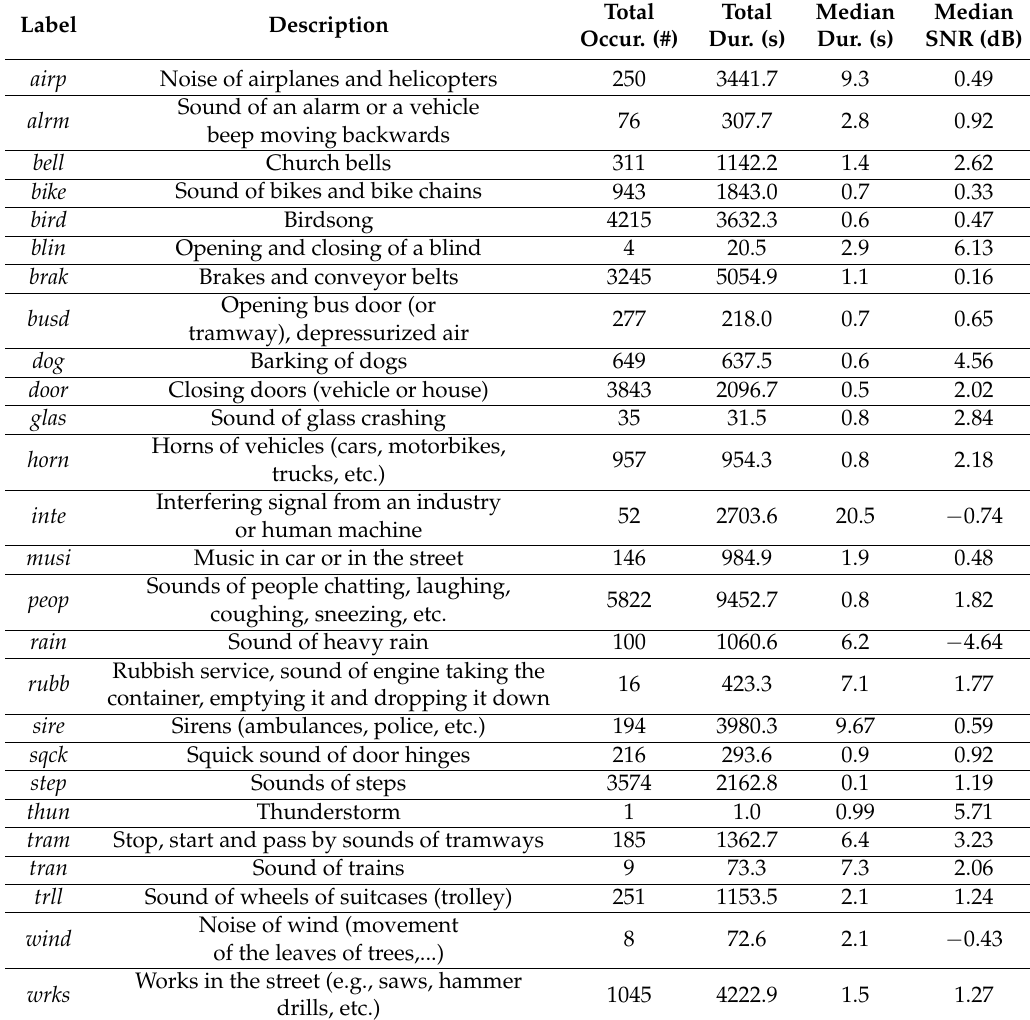
Table 2. Description of the 26 sound subcategories of anomalous noise events, in alphabetical order, identified during the manual labelling process of the WASN-based urban acoustic database, showing the number of occurrences, their total duration (in s), median duration (in s) and median signal-to-noise ratio (SNR) (in